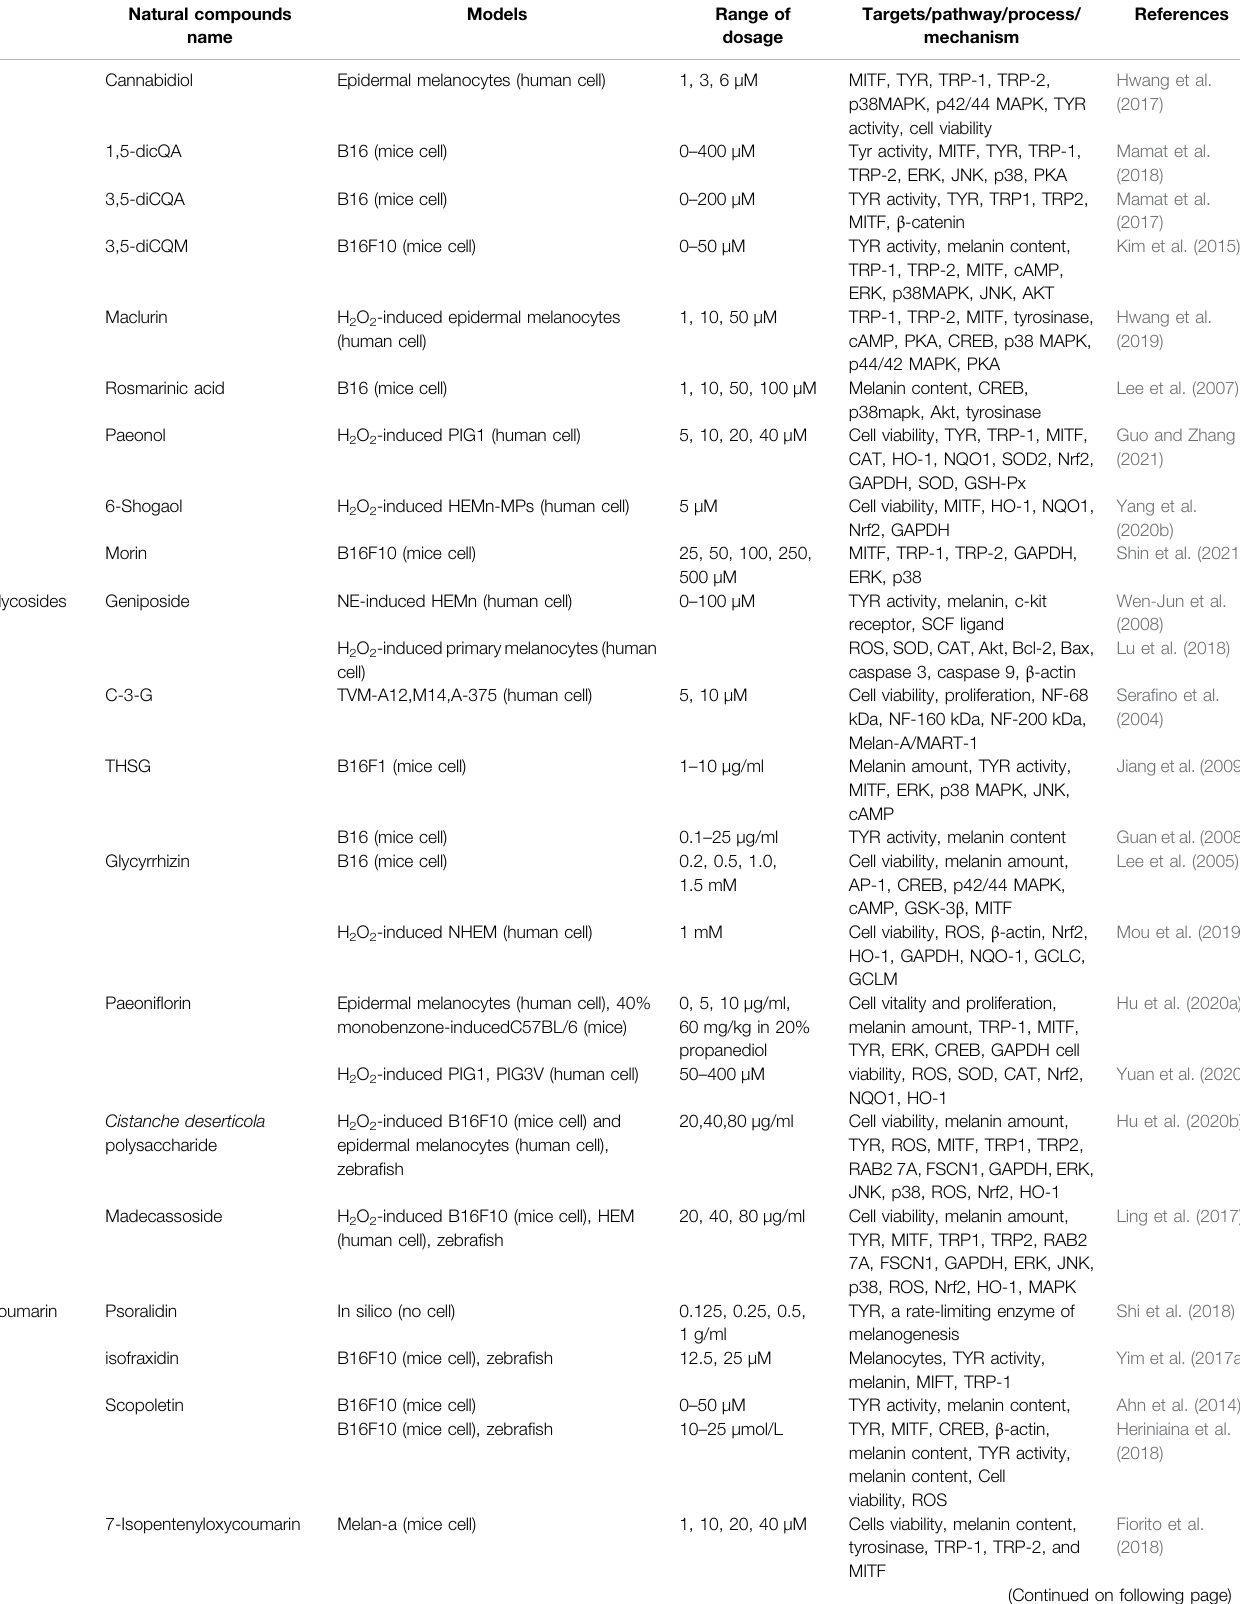
TABLE 1 | ( Continued ) Summary of natural products for the treatment of vitiligo in